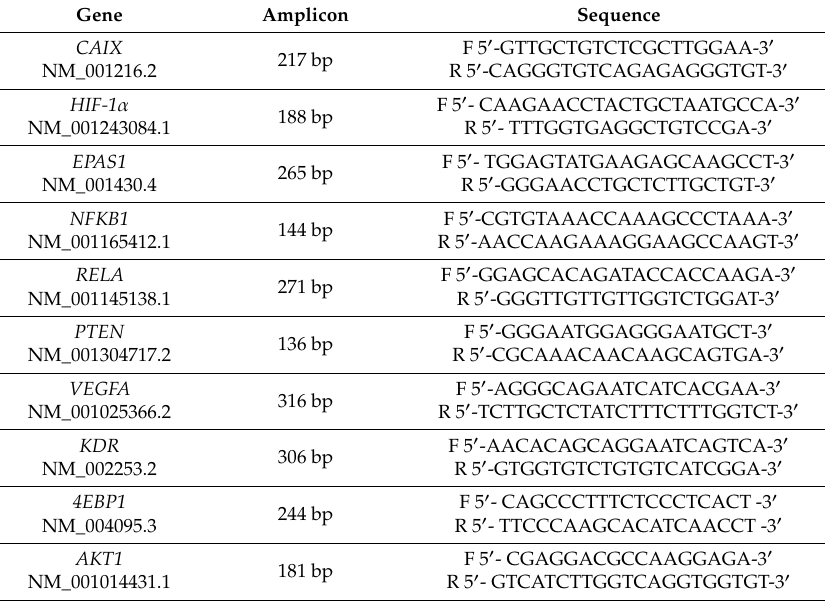
Table 1. The sequence of